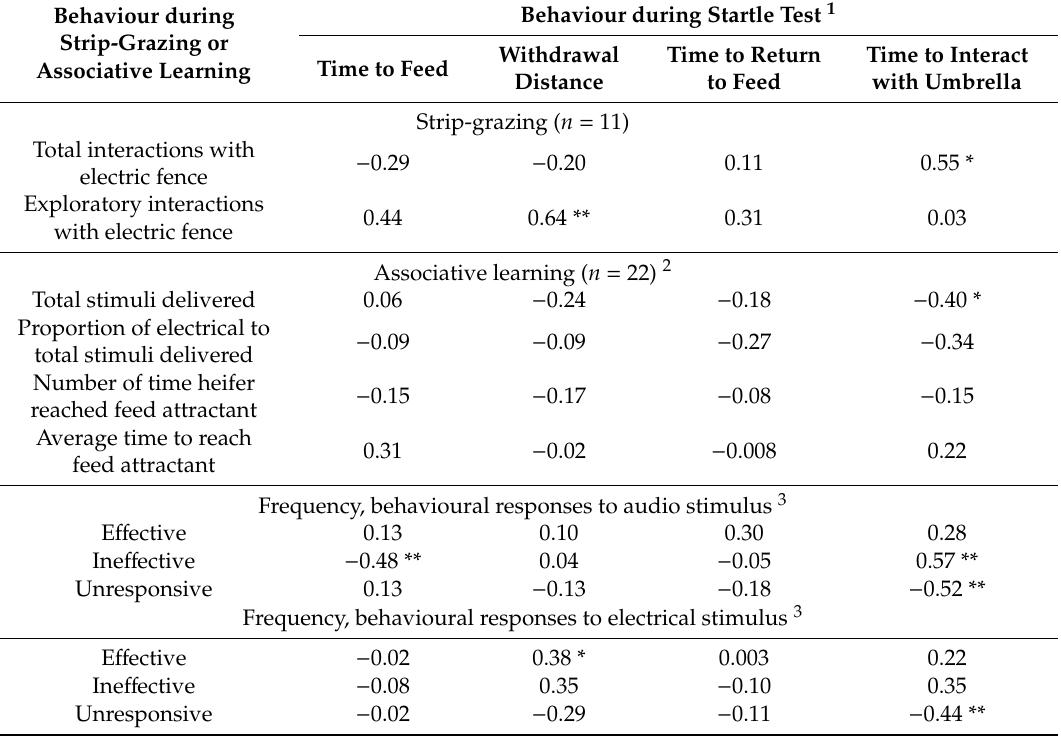
Table 3. Spearman rank correlation coe ffi cients between heifer behaviour in startle test and that during